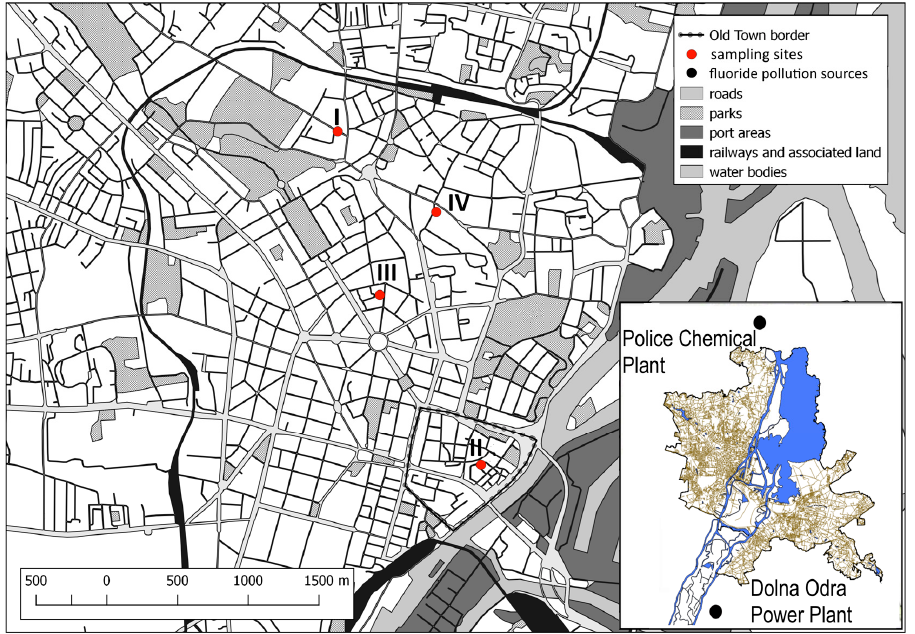
Figure 2. The location of sampling sites in the city of Szczecin (NW Poland). The oldest part of the city. Sampling site I—smithy of horseshoes and vehicle parts; II—smithy of horseshoes and vehicle parts; III—smithy of horseshoes and vehicle parts; and IV—nail smithy.